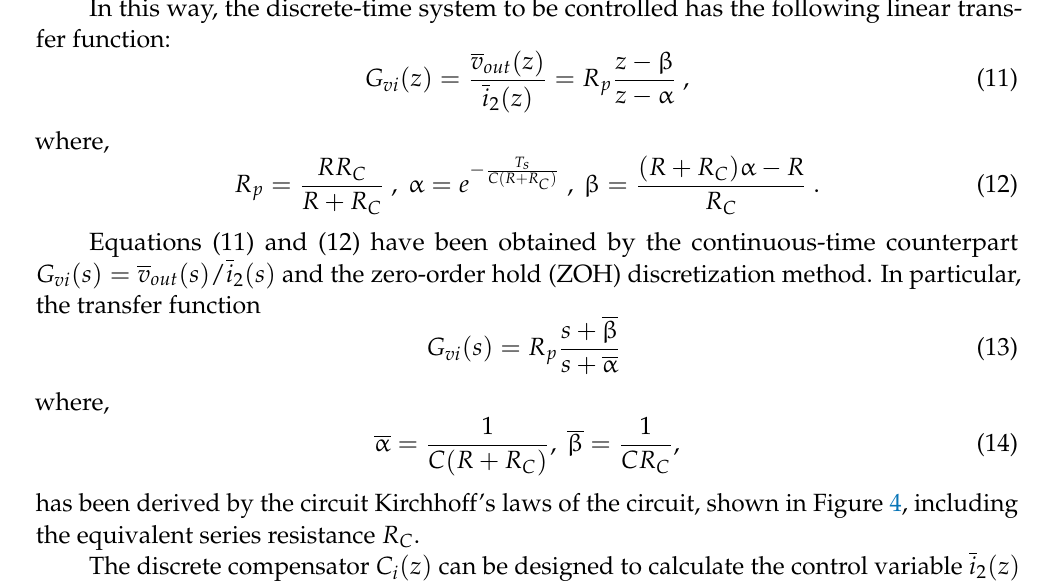
Figure 7. The proposed voltage control